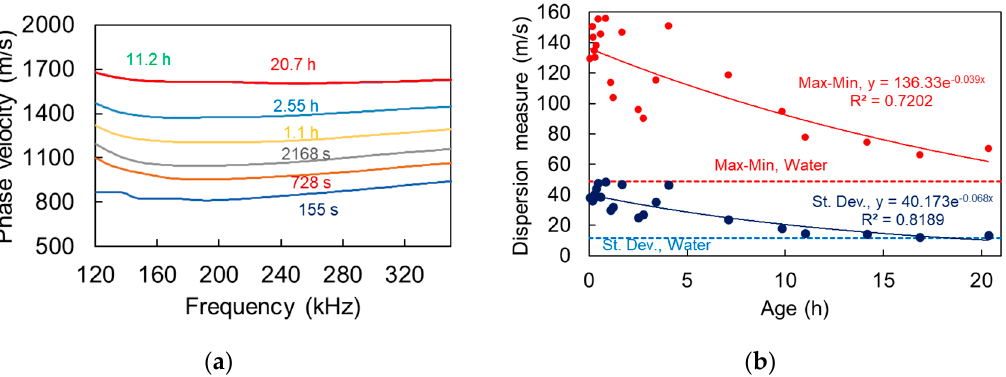
Figure 7. ( a ) Phase velocity vs. frequency for different times and ( b ) dispersion measures vs. time after bubble creation in shampoo.